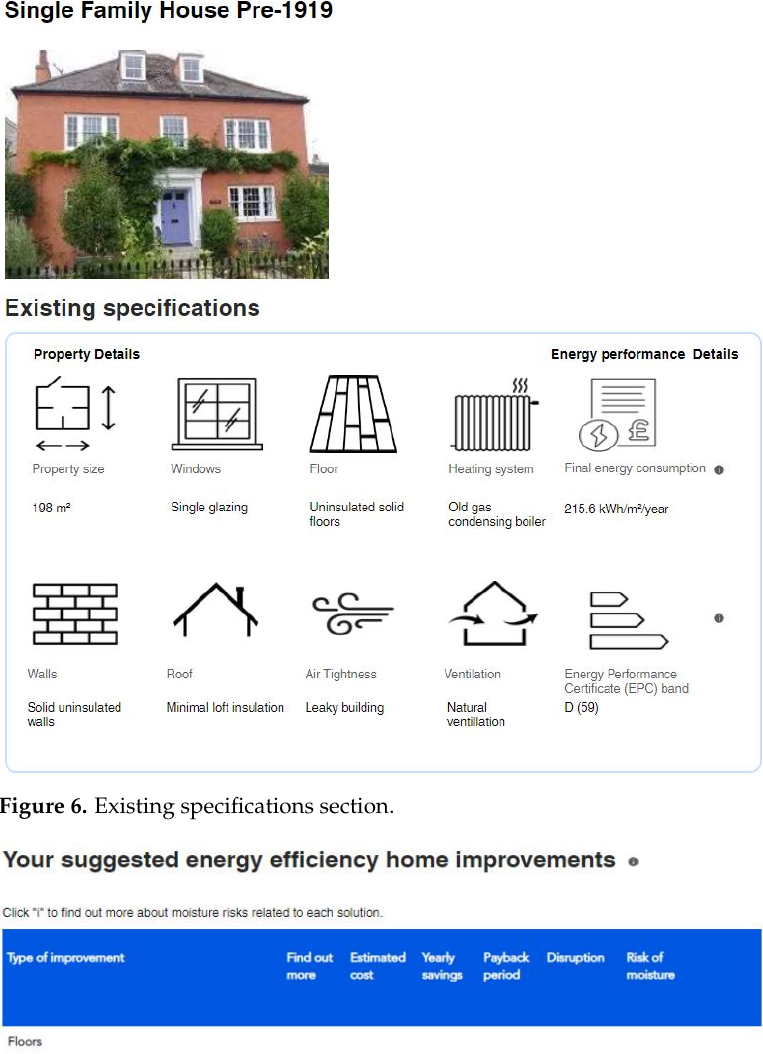
Figure 6. Existing specifications section.